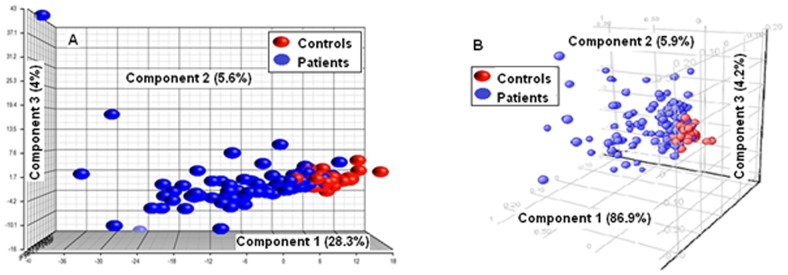
Comparison of Principal Component Analysis (PCA) with 390 and 15 selected plasma apparent lipid species.A: The first component in PCA cross all 390 detected plasma apparent lipid species accounts for 28.3% of the overall variance; B: The first component in PCA cross 15 selected plasma apparent lipid biomarkers accounts for 86.9% of the overall variance.